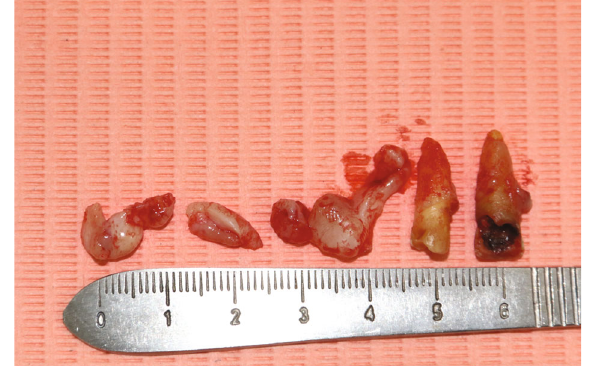
Figure 4: External bevel incision gingivectomy of the lower left quadrant and exodontia of #33, #34, and #35.